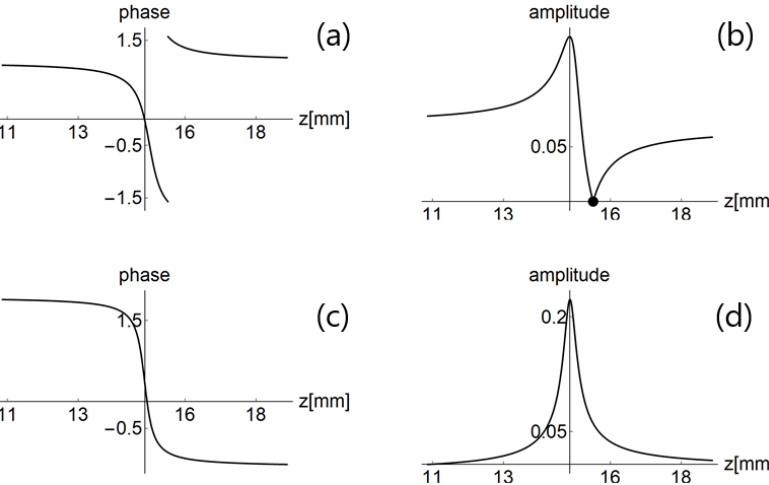
Figure 7. The phase ( a ) and amplitude ( b ) distribution of the 1/ A ( 2 ) in case of system with the separated SPP and focusing lens as a function of focusing lens position in respect to the sample plane. In ( c , d ) the phase and amplitude distribution of the 1/ A ( 1 ) term is shown in case of SPP and focusing lens working as a single element (with no